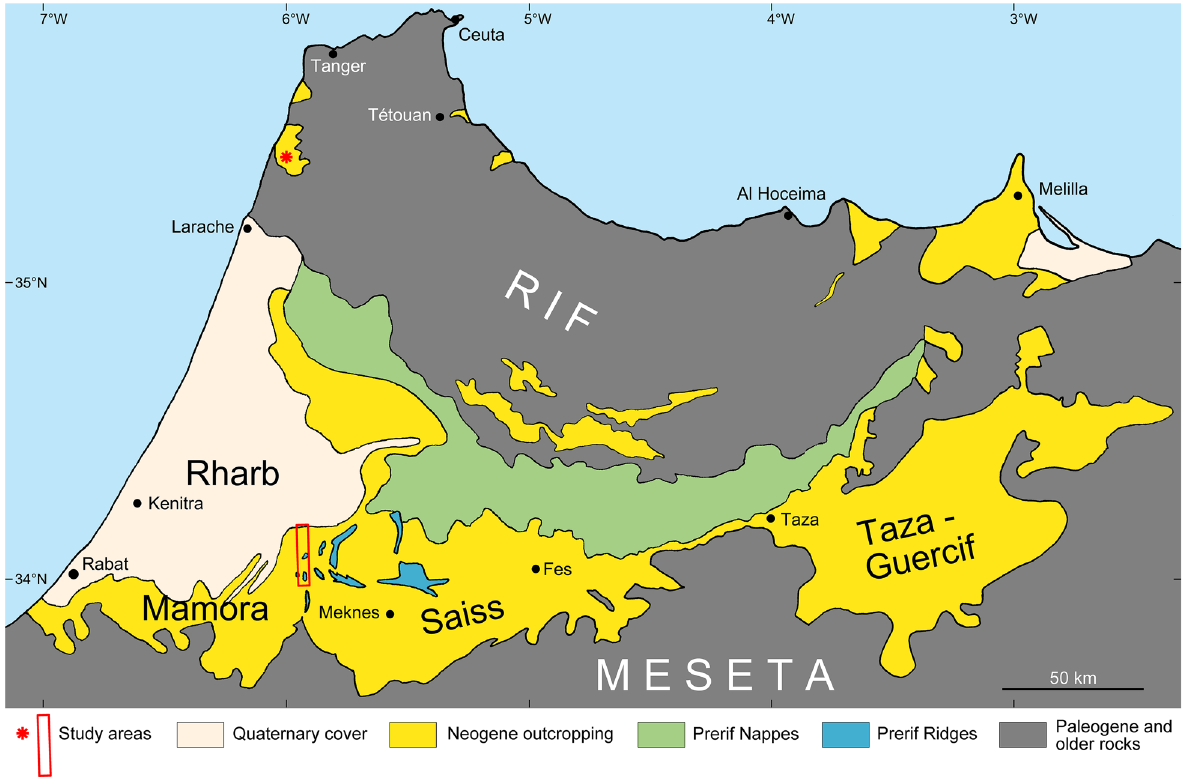
Fig. 1 Regional map of northern Morocco outlining distribution of Neogene sediments. Schematized and simplified after the detailed map published by Saadi et al. (1980). The study areas highlighted are the Oued Beth outcrop section (red rectangle) and the Asilah outcrop (red